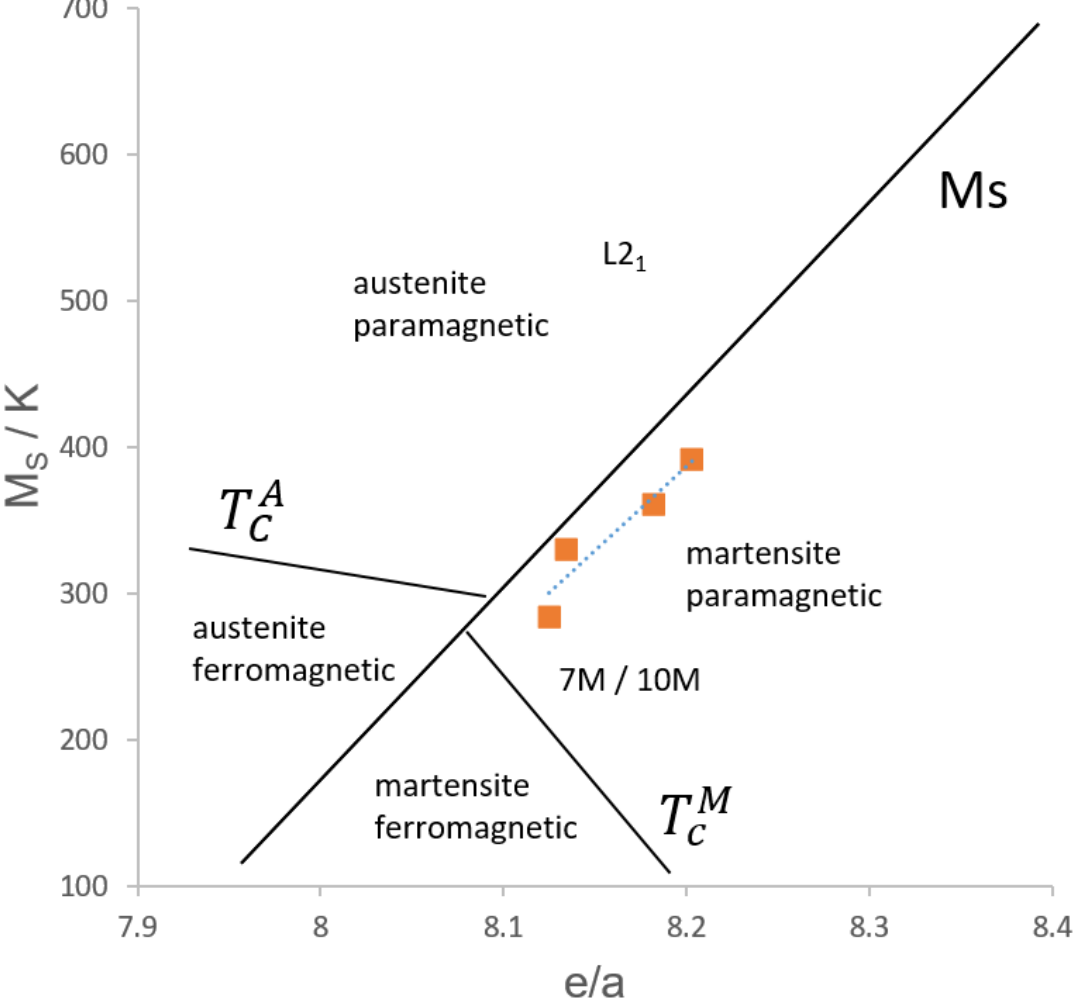
Figure 5. Phase diagram (martensite start versus e / a). Adapted from reference [27] (squares this work).